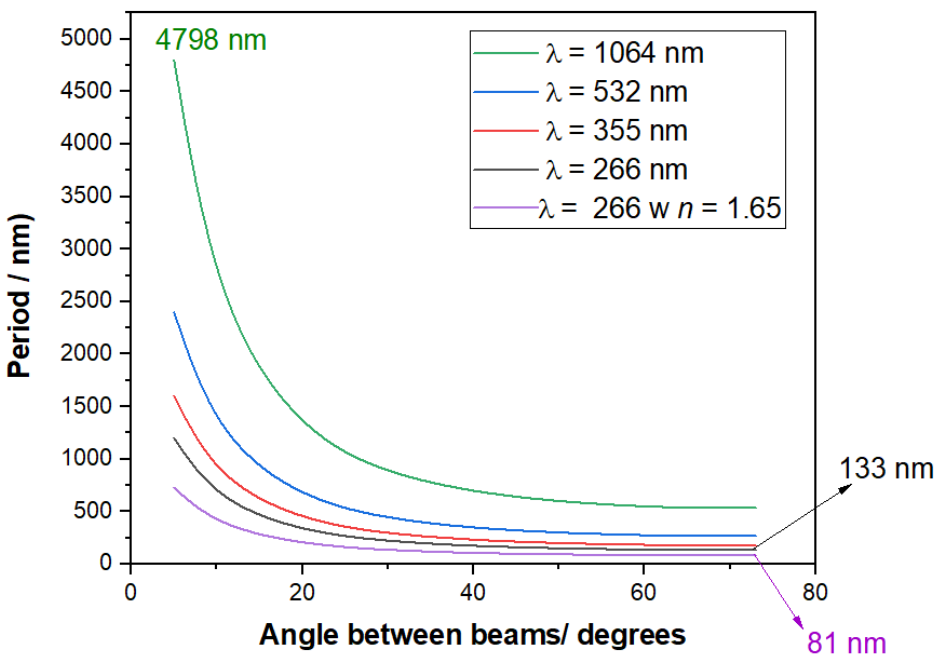
Figure 2. Effect of angle between beams, wavelength of the light, and refractive index of the external medium.